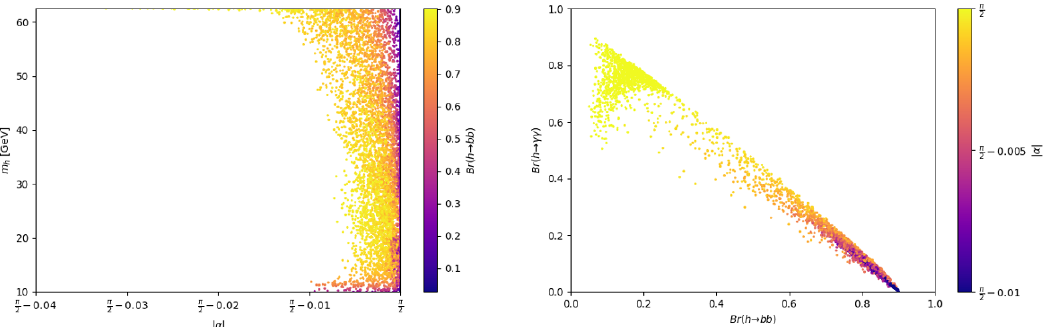
Figure 1. Left panel: BR( h ! b (cid:22) b ) mapped over the ( j (cid:11) j , m h ) plane. Right panel: correlation between BR( h ! b (cid:22) b ) and BR( h ! (cid:13)(cid:13) ) as a function of j (cid:11) j . We assume here the